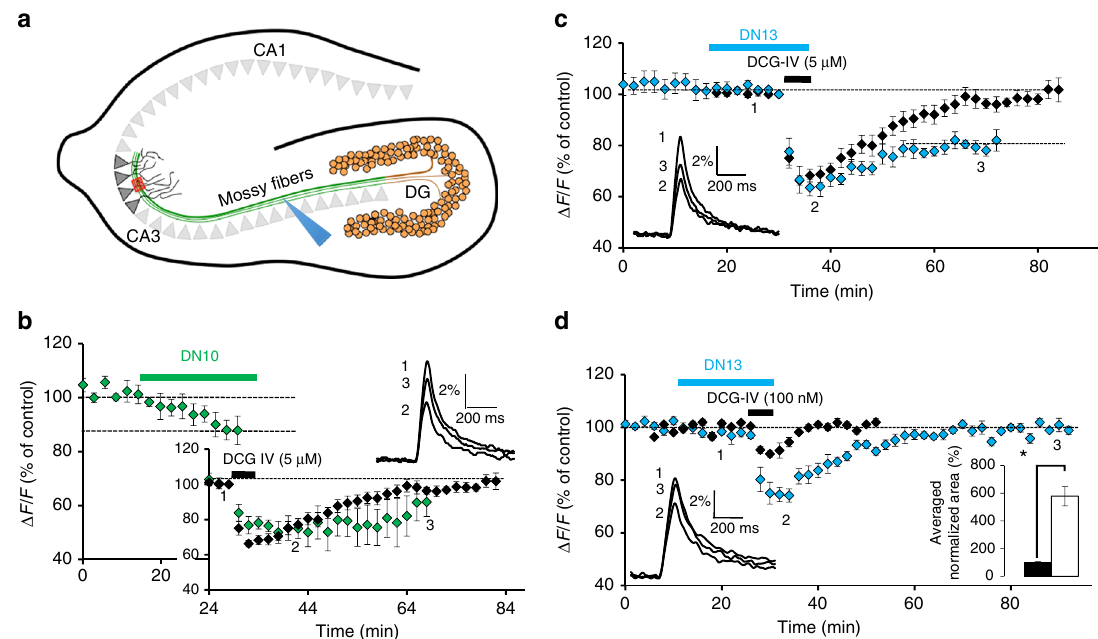
Fig. 5 DN10 and DN13 enhance DCG-IV effect at mossy fi ber terminals in the CA3 hippocampal area. a A schematic view of the hippocampus illustrating the granule neurons of the dentate gyrus (DG) projecting to the pyramidal neurons in the CA3 area via the mossy fi bers. b DN10 inhibits the presynaptic calcium transients evoked by electrical stimulation of the mossy fi bers (blue arrowhead in a ) in the CA3 area (red box in a ) and prolonged the inhibitory effect of saturating concentrations of DCG-IV (5 µ M) (large inset). In this and all other panels, data are plotted as normalized amplitudes of peak fl uorescence transients ( Δ F / F ) evoked by fi ve stimulations of mossy fi bers (delivered at 100 Hz). In the inset, data are normalized to the base line to better illustrate the difference in off rate kinetics. c DN13 slows the off rate kinetics of the DCG-IV (5 µ M) inhibitory effect. d DN13 potentiates the inhibitory effect of a low concentration of DCG-IV (100 nM) on evoked presynaptic calcium transients. Right inset in d shows the average normalized area corresponding to the depressant effect of DCG-IV alone (black bar, 100 ± 5.4%, n = 10) and in the presence of DN13 (white bar, 578.5 ± 69%, n = 9), P < 0.001. Left inset in c , d and top inset in b display superimposed fl uorescence changes in one of these experiments recorded at the indicated times. Each trace in b – d are an average of 10 consecutive trials. Since the variance was different between DCG-IV and DCG-IV+ DN13 groups, the Welch test was applied for statistical